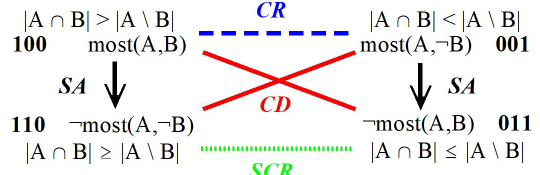
Figure 3. Classical square with bitstrings of length 3 for F most , relative to FOL